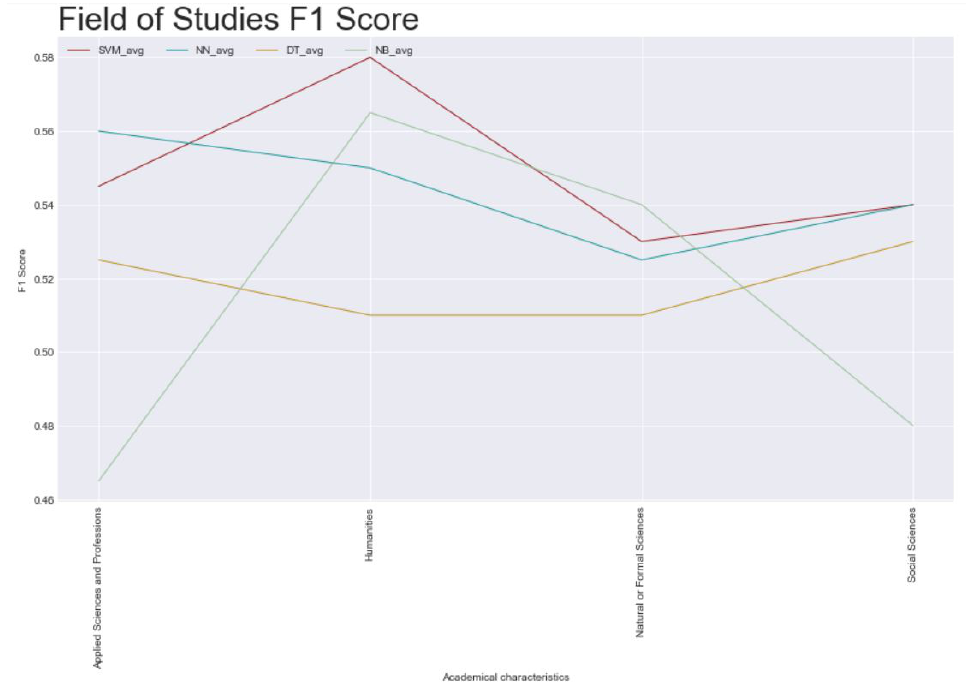
Figure 4. Variation of the F1 Score along the different tables related to variable field_of_studies modelled and